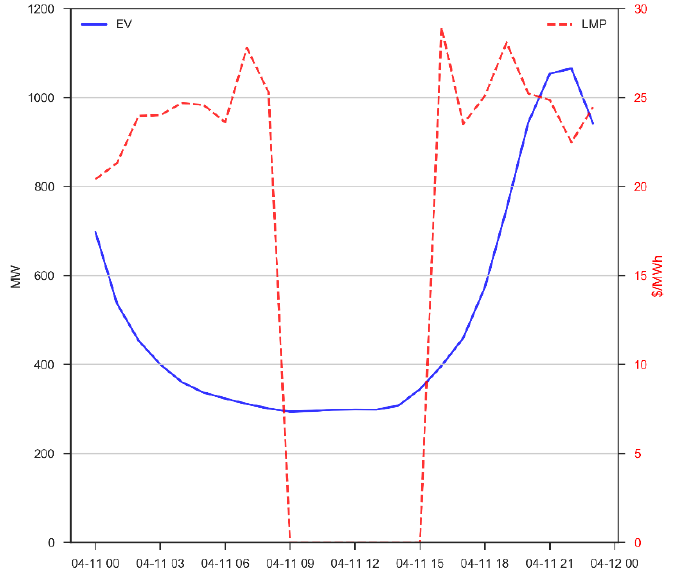
Figure 18. EV load and LMP results for one day during Duck week, including 30% EVs being implemented with uncoordinated charging.